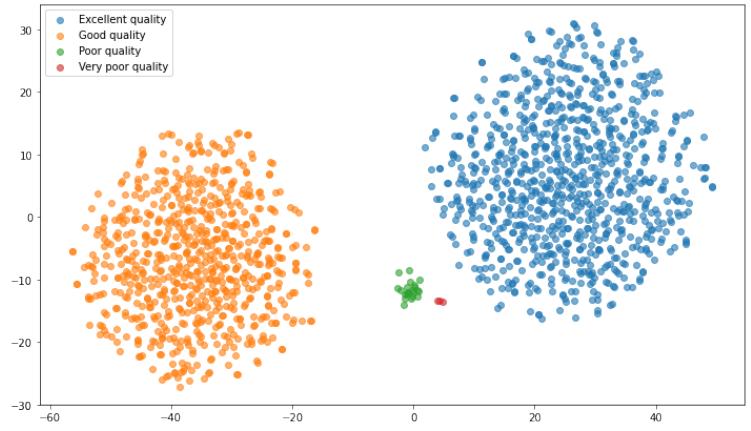
Figure 7. Embedding visualization of the constructed WKG. Figures 8 and 9 depict respectively the water zones with poor and very poor water quality.